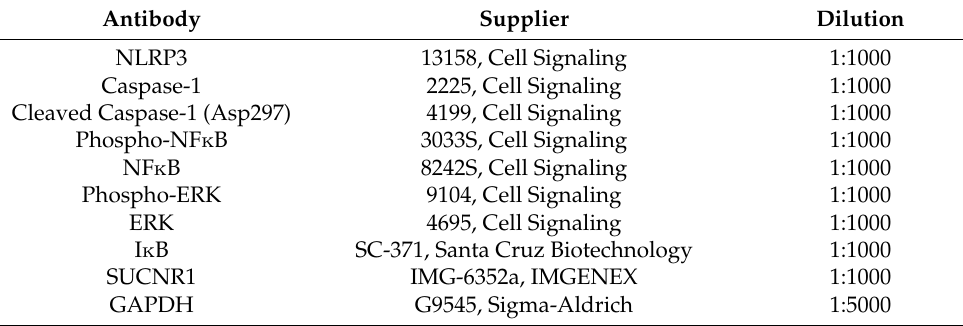
Table 2. Primary antibodies used for Western Blot